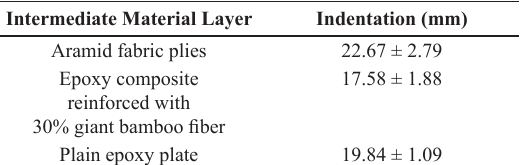
Table 1. Average depth of intrusion in the clay witness backing different multilayered